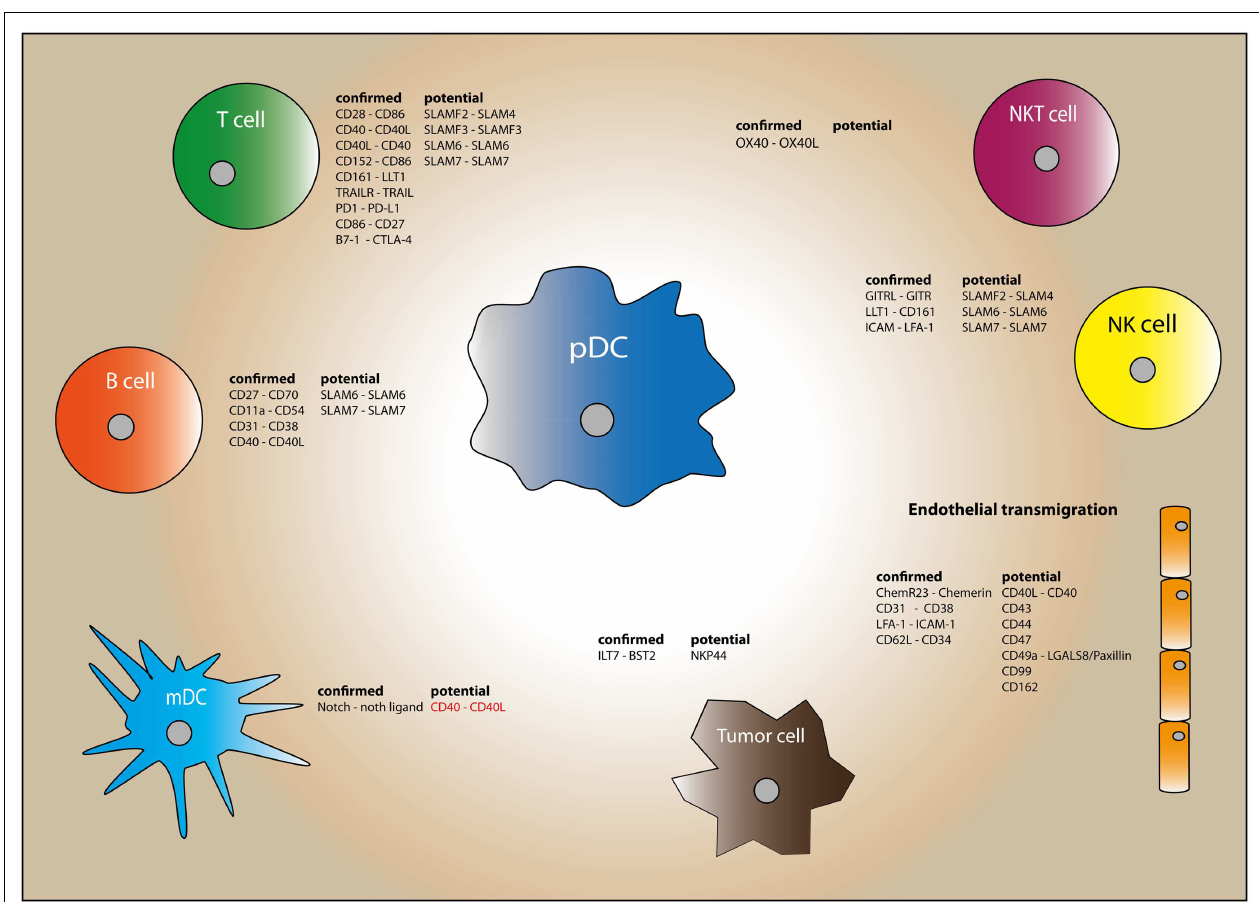
a functional effect. Molecules listed in the “potential” column are molecules that have been found on human pDC but without functional data reported in literature. Molecules playing a potential role in humans, but already confirmed with functional studies in mouse are depicted in red.